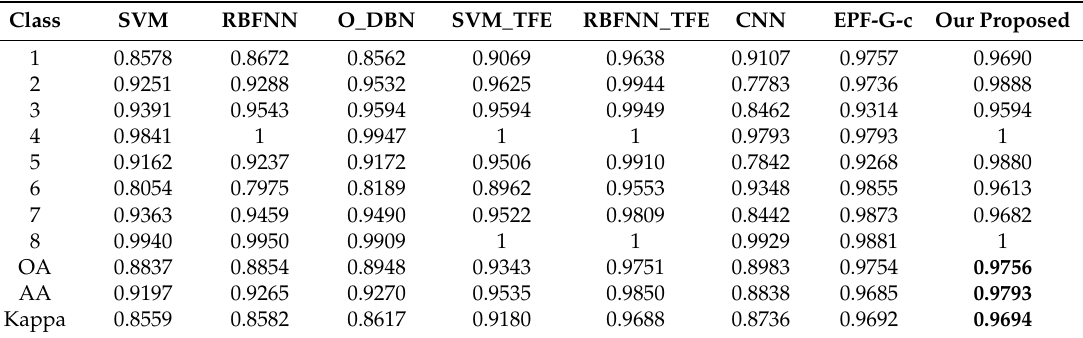
Table 6. Classification accuracy of different algorithms on Indian Pines.